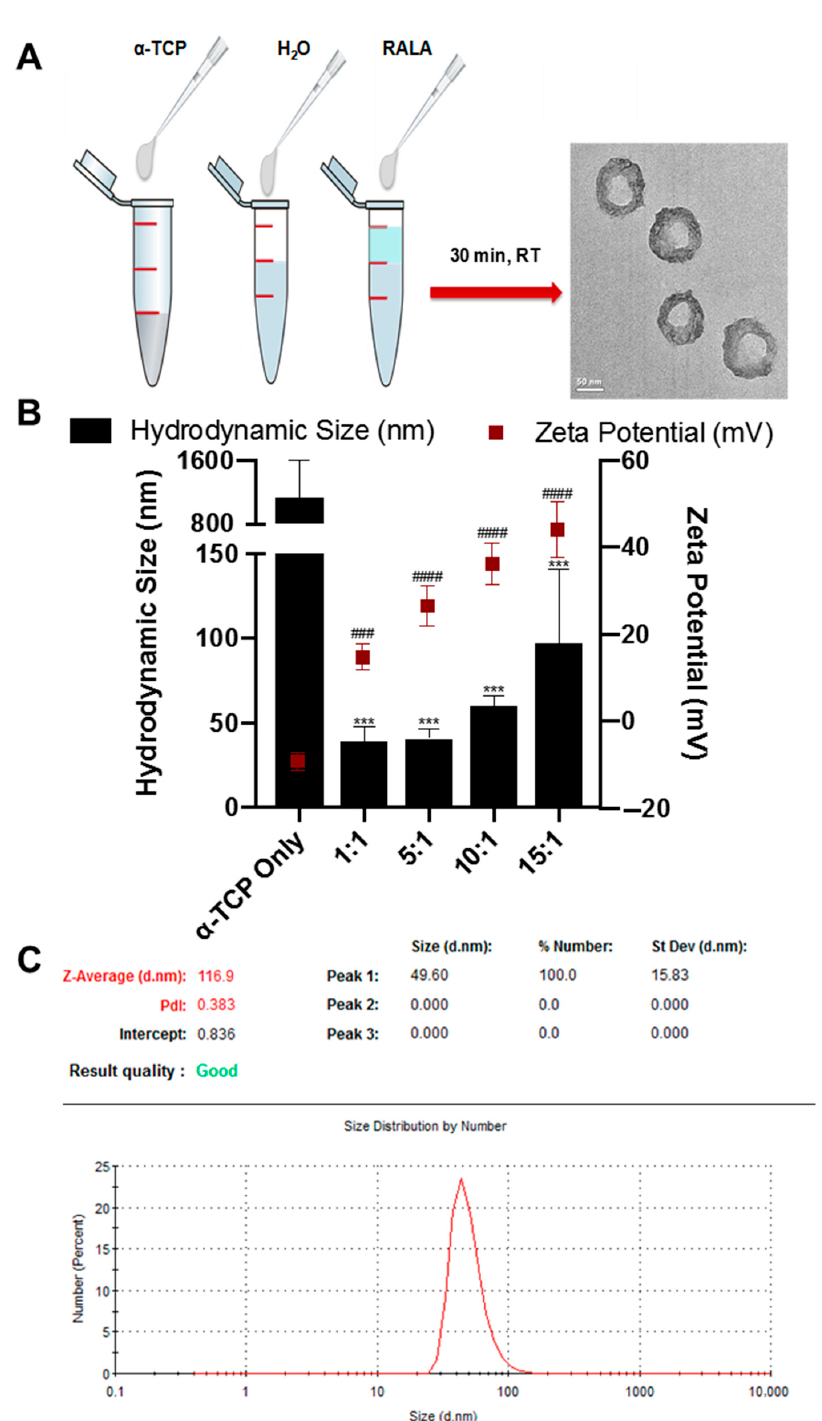
Figure 2. Formulation and characterization of cationic 30 mer amphipathic peptide (RALA) / α -TCP NP. ( A ) RALA / α -TCP nanoparticles (NPs) were prepared by mixing 1 µ g α -TCP with reconstituted RALA (lyophilized) at varying mass ratios. Particles were then incubated at room temperature for 30 min. Formulation and morphology of the NPs was confirmed by TEM. (Scale bar = 50 nm). ( B ) Particle size and zeta potential of RALA / α -TCP NPs after formulation at mass ratios (RALA: α -TCP) 1, 5, 10 and 15. The RALA peptide e ff ectively condenses α -TCP into positively charged nanoparticles < 100 nm in size up to mass ratio 15. Significant di ff erences are denoted by the symbols (*) for hydrodynamic size and (#) for zeta potential, compared to α -TCP Only (N = 3 ± SEM) *** = p < 0.001, ### = p < 0.001, #### = p < 0.0001. ( C ) representative size distribution by number of RALA / α -TCP